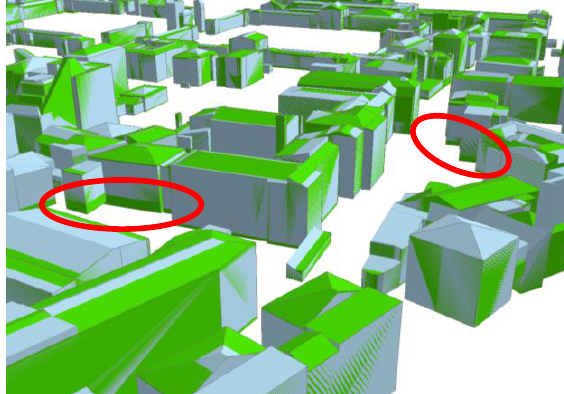
Figure 7. Test area and surveyed buildings for 3D model vs. ground-truth comparison: significant height differences are at the building base.